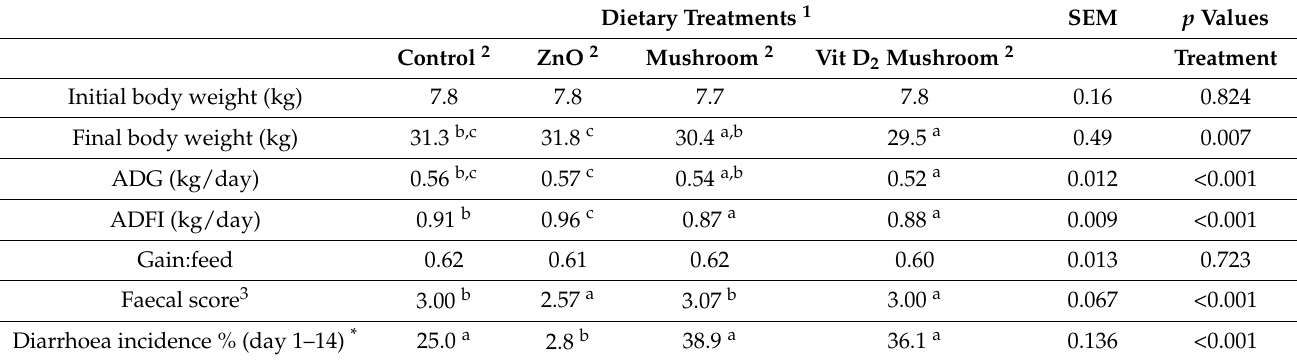
Table 3. Effect of dietary treatment on pig growth performance (day 1–45; least square means with their standard errors).